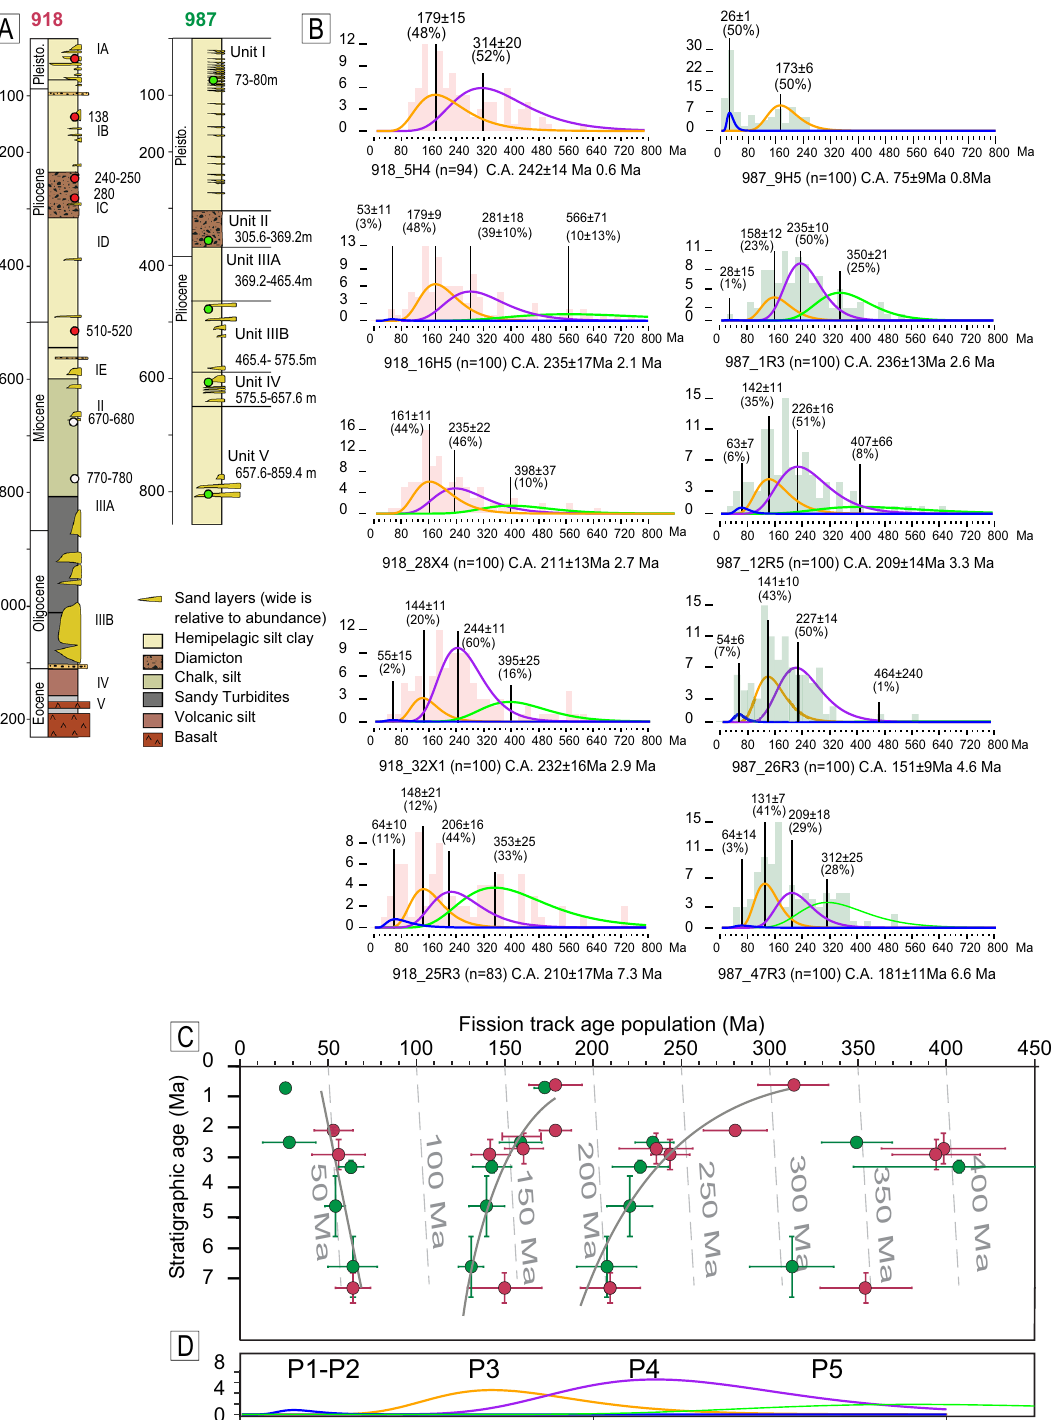
Figure 2. ( A ) Stratigraphic log with locations of sampling spot, in modified from 8,9 . ( B ) Histograms of AFT grain age and decomposition into a population of ages. The number in brackets is the number of dated grains. C.A. is the central age, the age of the undecomposed distribution. ( C ) Lag time plot where the ages of populations of detrital fission-track data are plotted against stratigraphic ages. The samples obtained from site 918 are represented in red, while those obtained from site 987 are represented in green. Curves represent a regression of P2, P3 and P4; see Supplementary Figure S1. Vertical dotted lines represent the same lag time as that corresponding to a constant erosion rate. ( D ) Decomposition into populations of the distribution obtained from the sum of the ages of all samples, using Binomfit 22